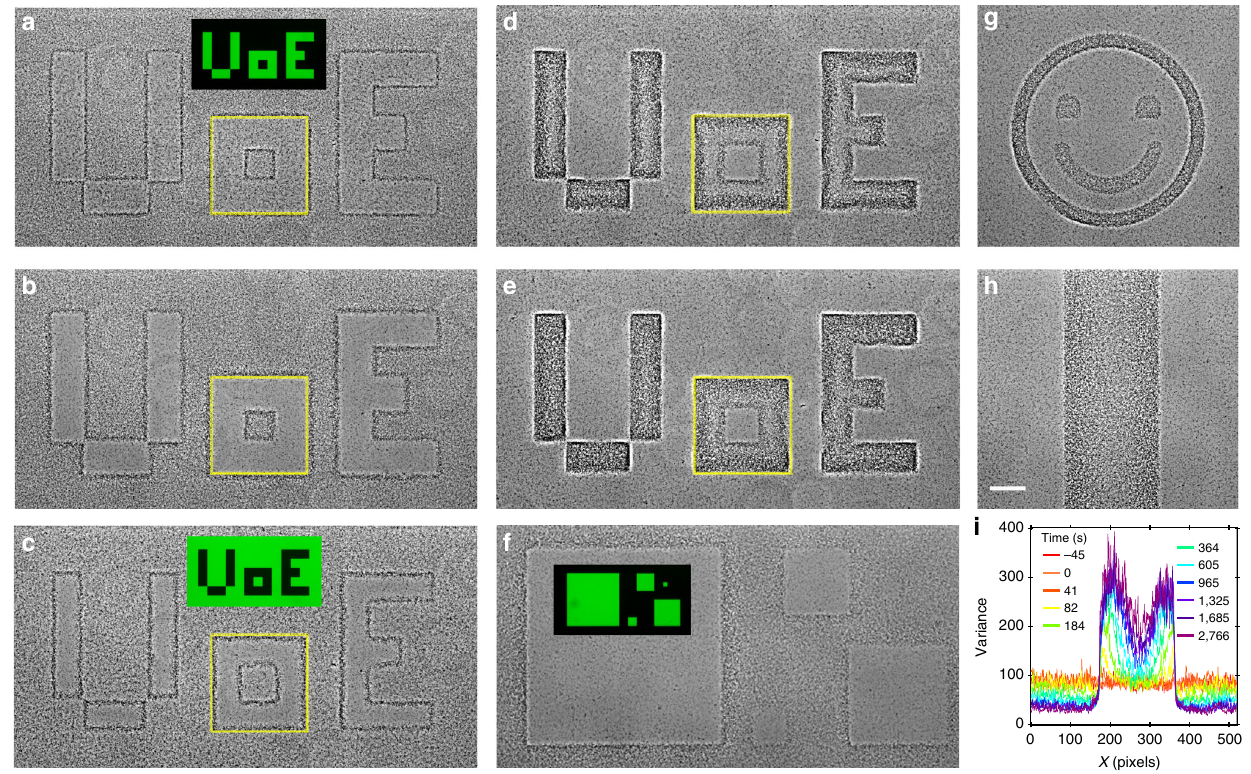
Fig. 2 Smart templated active self-assembly. Positive and negative masks projected onto initially stationary cells: a sample illuminated for 1 min with a positive ‘ UoE ’ (University of Edinburgh) pattern shown in inset, b same after 9 min of illumination, c 1 min after switching to the negative pattern shown in inset (with green = bright), as well as d 6 min and e 12 min after switching. Yellow square = boundary between light and dark regions of the ‘ o ’ . f Samples illuminated with pattern of squares shown in inset. g Negative smiley pattern. h Negative strip together with i time evolution of the strip ’ s density pro fi le. Scale bar in h is 100 μ m and applies